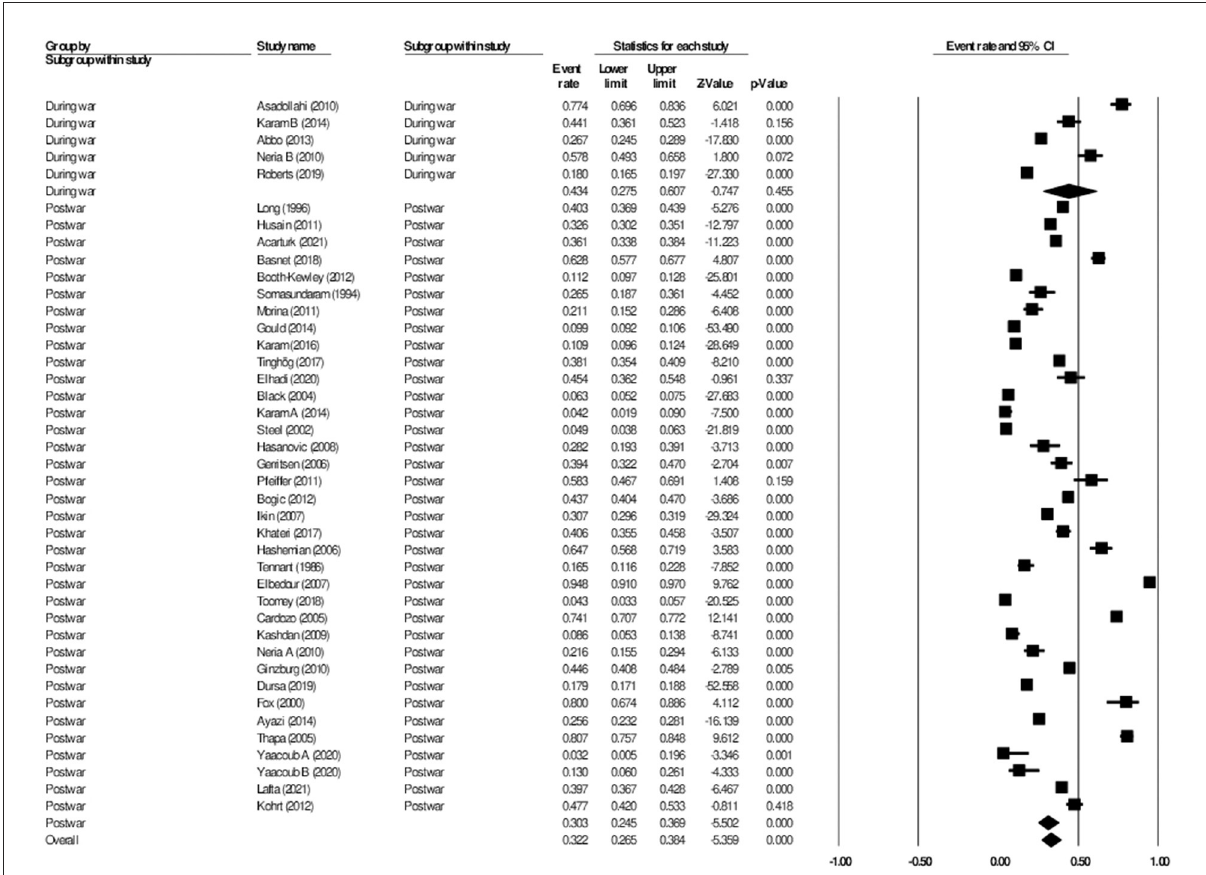
FIGURE5 Forest plot showing prevalence of anxiety, including analysis between during war and post-war